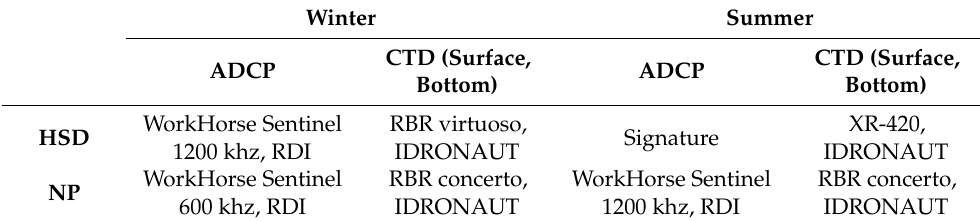
Table A1. Measuring instruments used in winter and summer.